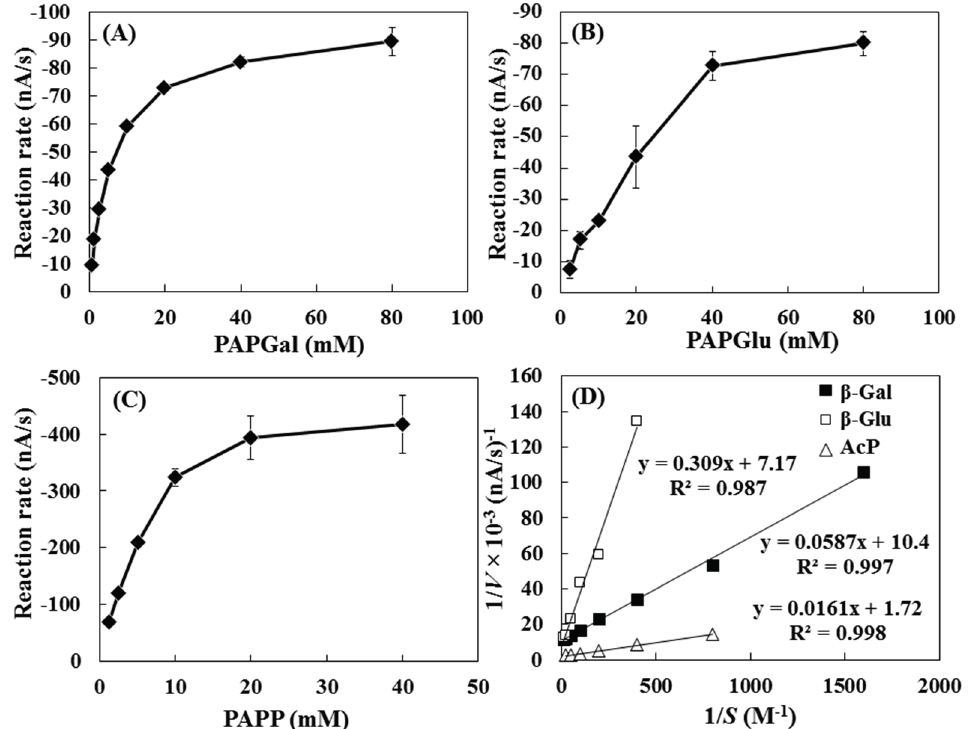
Figure 3. The hydrodynamic amperometric responses of ( A ) 0.0075 mg·mL − 1 β -gal; ( B ) 10 mg·mL − 1 β -glu and ( C ) 1.0 mg·mL − 1 AcP with different concentrations of substrate at 0.3 V applied potential, with rotation set at 3000 rpm; ( D ) Lineweaver-Burk plots